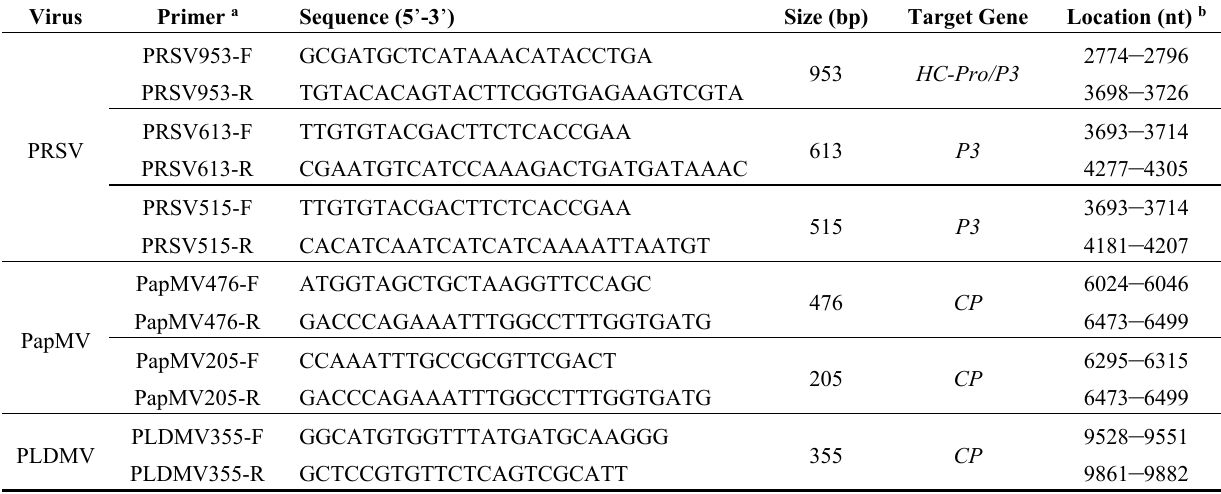
Table 1. List of primers used in the multiplex detection for PRSV, PLDMV, and PapMV.